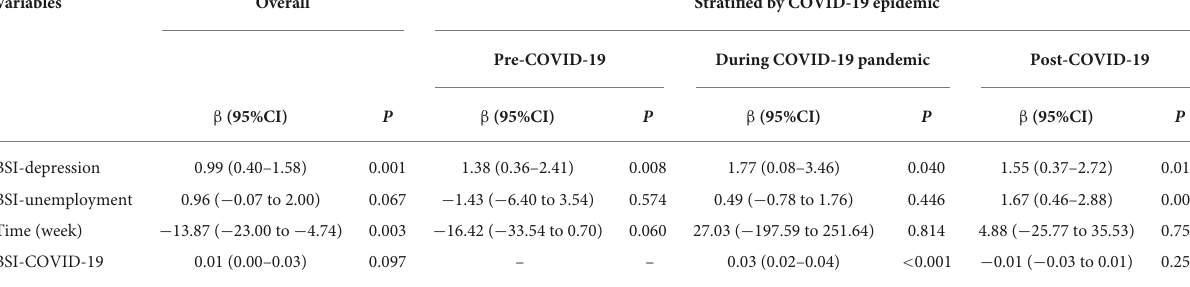
TABLE 2 Associations between Baidu Search Index (BSI)-COVID-19 and BSI-suicide pre-, during, and post-COVID-19 pandemic in China*.